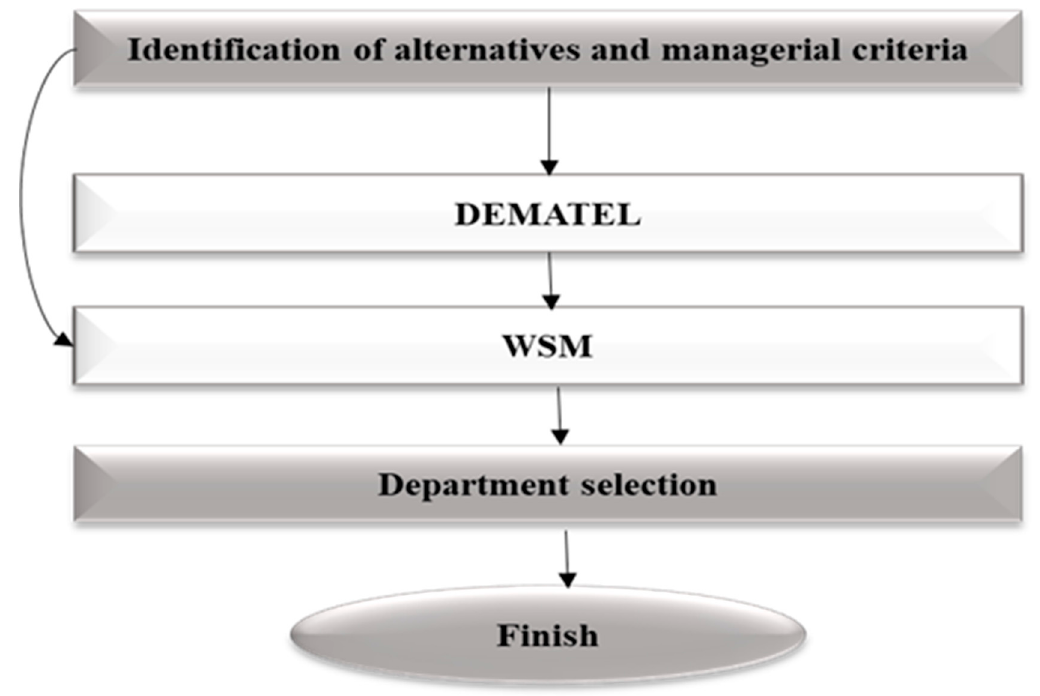
Figure 1. Flowchart of the rearchitecting of the healthcare facility (HF).